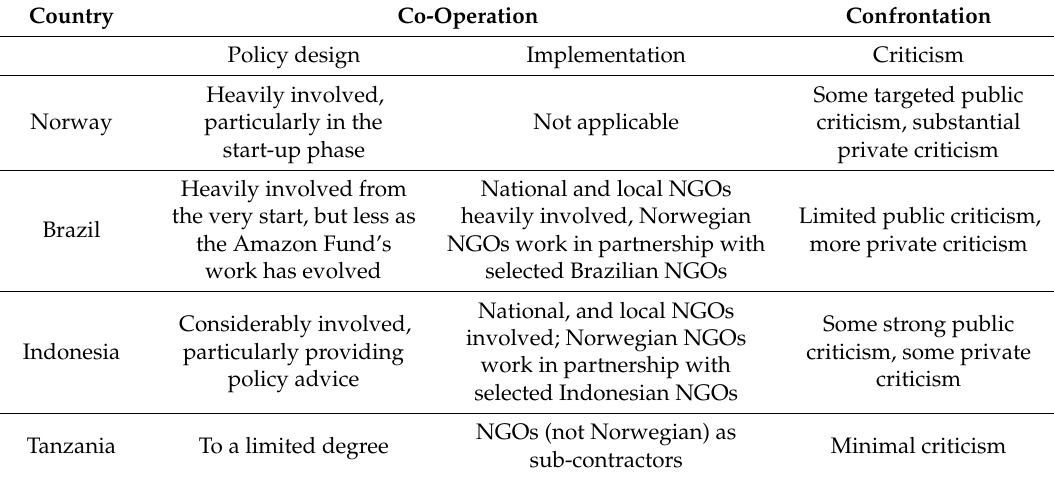
Table 2. A schematic comparison of different roles NGOs have taken regarding NICFI in Norway, Brazil, Indonesia and Tanzania.